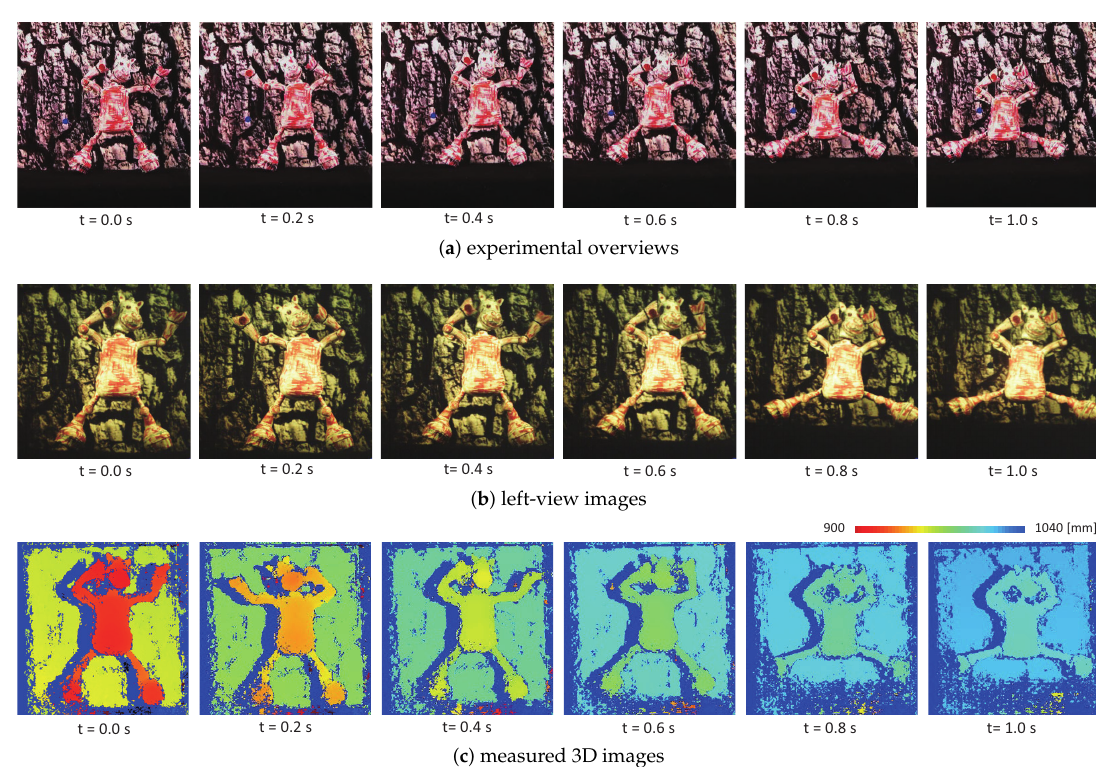
Figure 17. ( a ) Experimental overviews; ( b ) captured left-view images; and ( c ) measured 3D images of a dancing